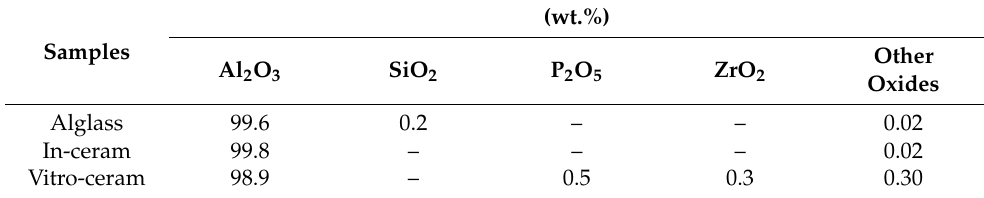
Figure 3. X-ray diffraction spectra of alumina samples: ( a ) Alglass, ( b ) In-ceram and ( c ) Vitro-ceram. A and Z denote α -alumina and zirconia phases, respectively. Table 2. EDX chemical analysis obtained for Alglass, Vitro-ceram and